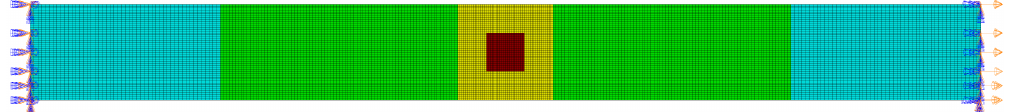
Figure 9. Meshing and boundary conditions of the model.